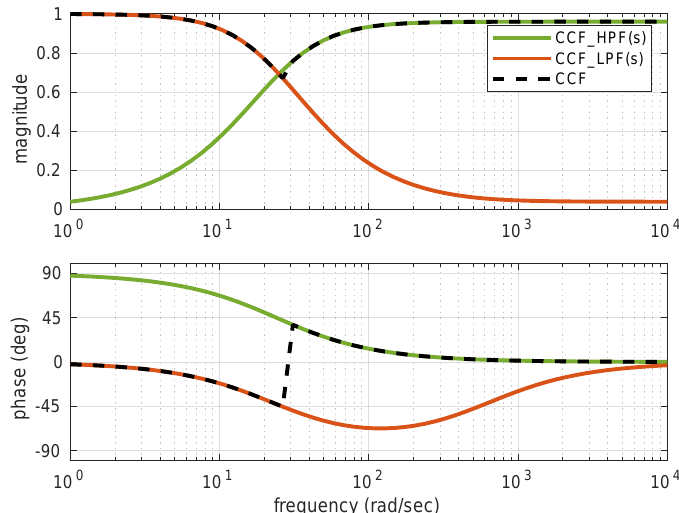
Figure 8. Amplitude and Phase plot for